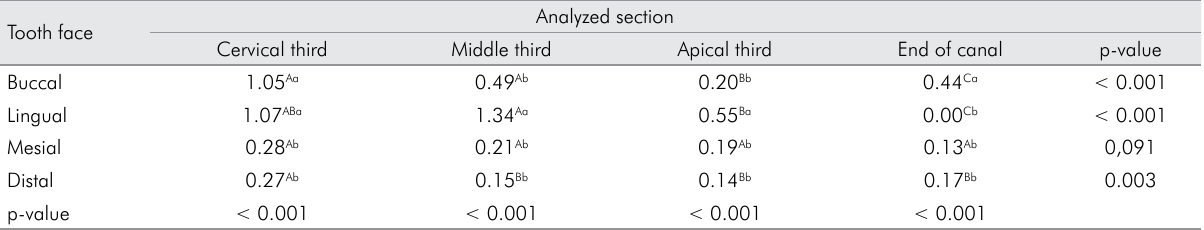
Table 2. Median values of the distance (mm) from the center position of the file to the limit of the root canal verified in root cross-sections Tooth